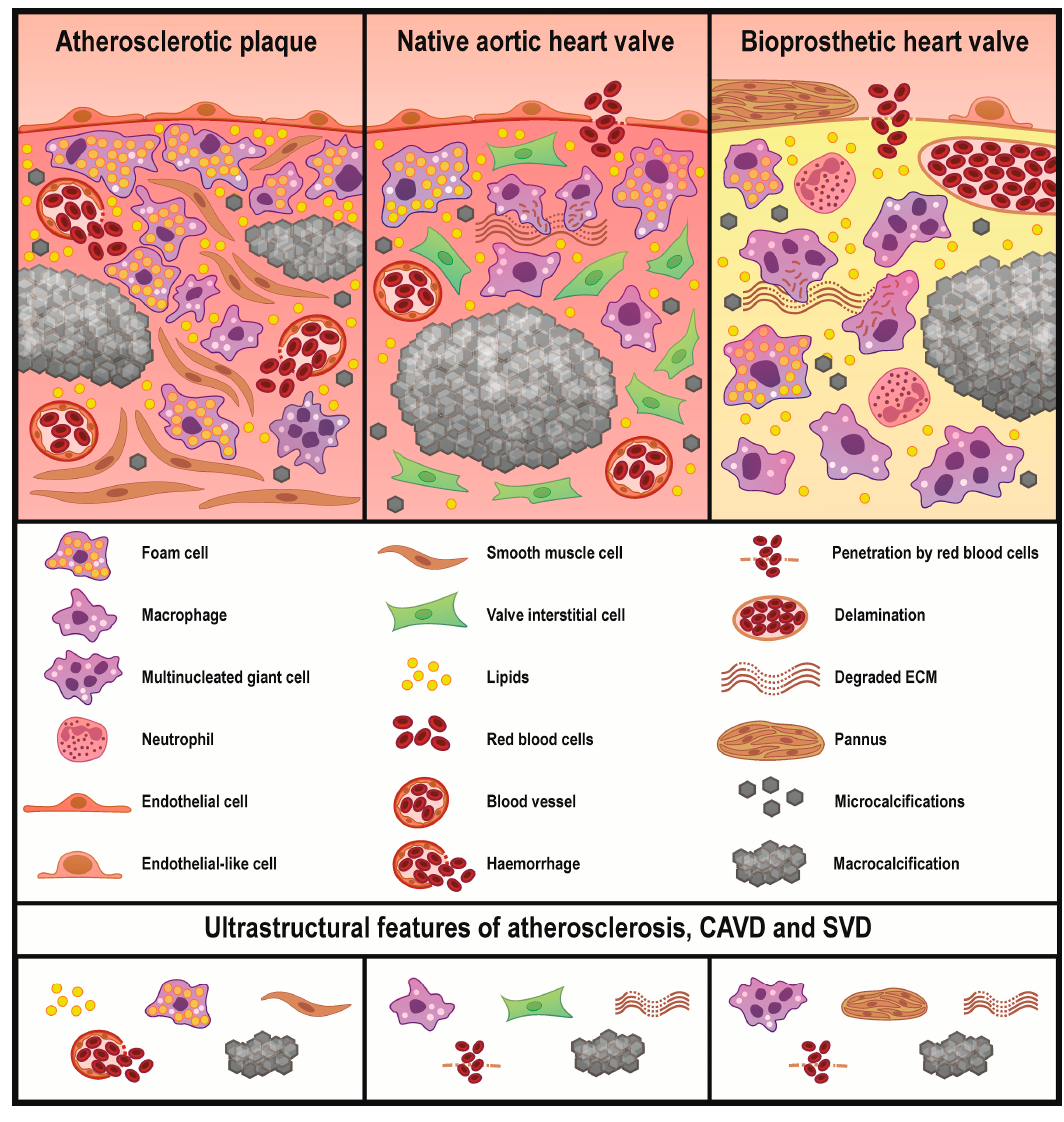
Figure 7. Common and unique ultrastructural features of atherosclerotic plaques, calcified native AVs, and failed BHVs. Atherosclerosis is mainly driven by a lipid retention accompanying by a foam cell formation. Subsequent migration and phenotypic switch of the vascular smooth muscle cells, active neovascularisation, and mineralisation further promote the development of atherosclerosis. Foam cells are also observed in the native AVs and BHVs, yet in considerably lower amounts, in particular when compared with non-lipid-laden macrophages. The highest macrophage diversity is observed in BHVs which additionally contain ECM-degrading / ECM-scavenging macrophages and multinucleated giant cells. In BHVs, mesenchymal cells form large outgrowths of a connective tissue which is termed pannus. Both heart valve types are characterised by protease- and fatigue-induced ECM degradation. Calcification and haemorrhages are common for all studied disorders, albeit intraplaque haemorrhages are caused by a neovessel leakage, while intravalvular bleedings are triggered by a loss of the ECM